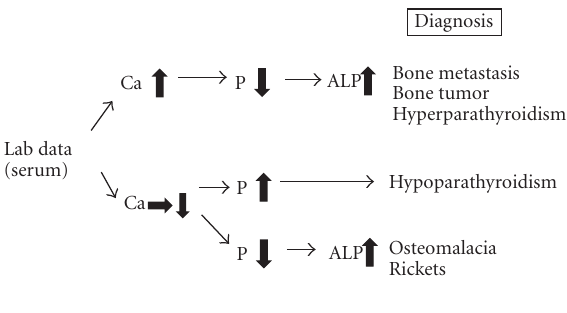
Figure 3: Scheme of di ff erential diagnosis of bone metabolic